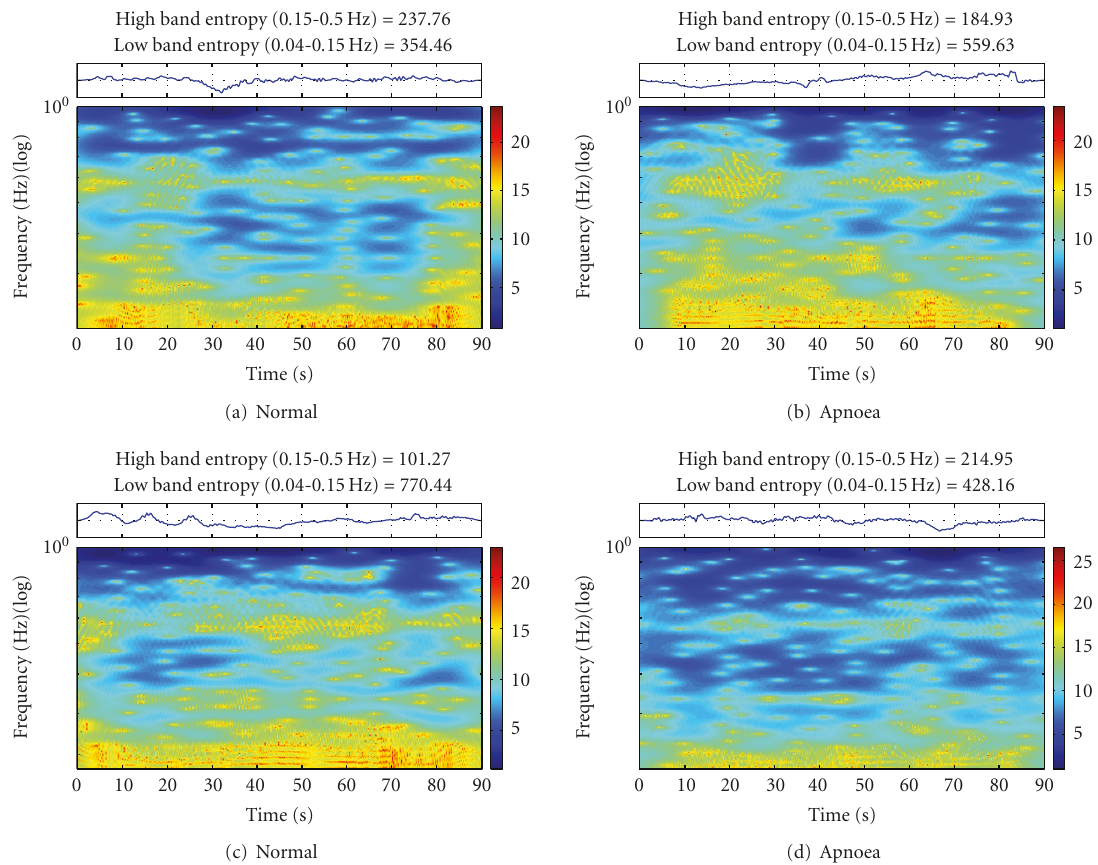
Figure 3: Estimated TFR for examples of segments of 90-second length of the PPG envelope signals having labels: normal or apnoea, respectively.